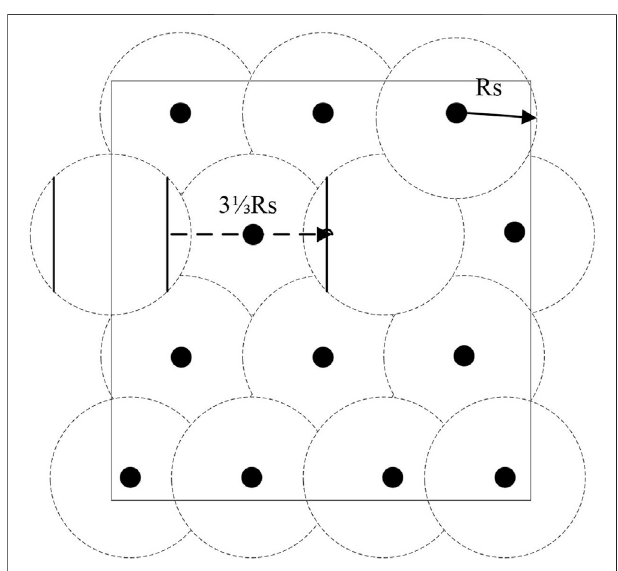
FIGURE 4 | Number of equivalent nodes covering